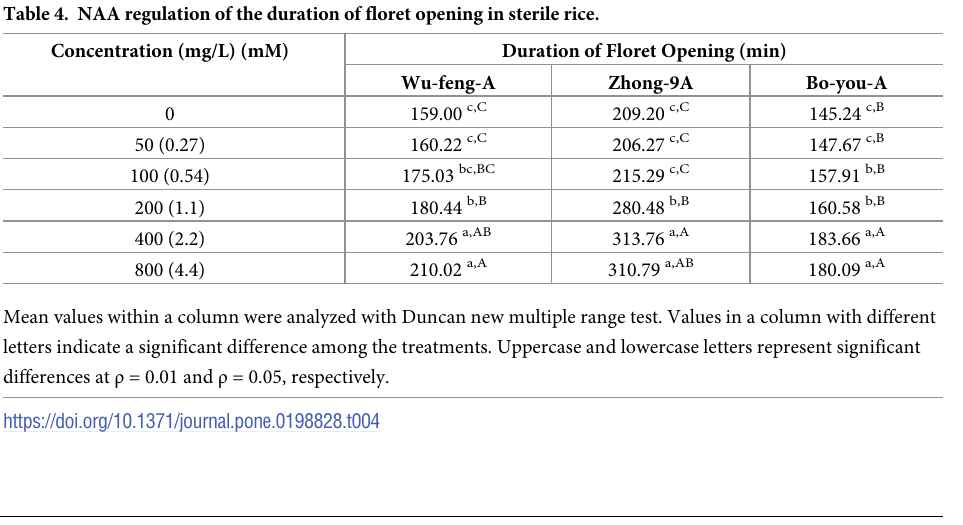
Table 4. NAA regulation of the duration of floret opening in sterile rice.